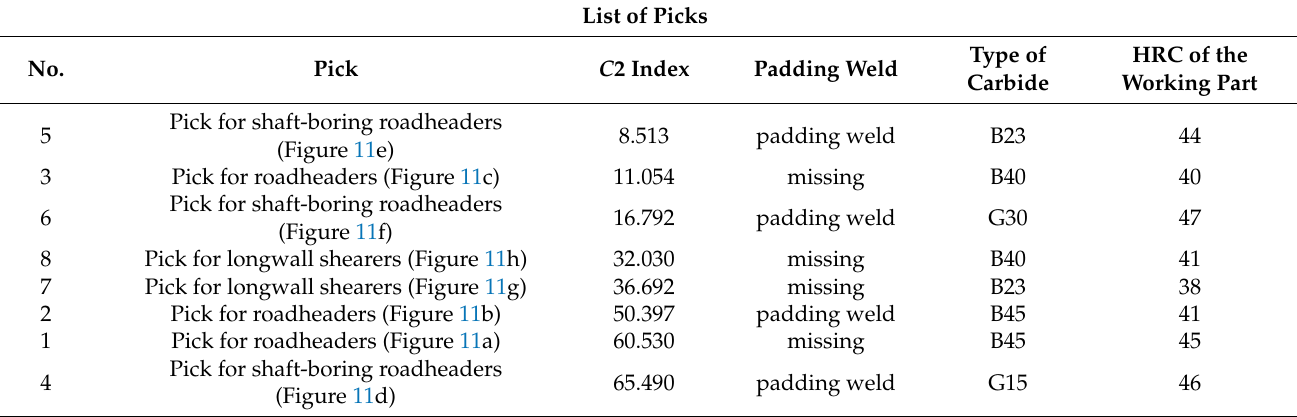
Table 9. Summary of the results of average values for individual